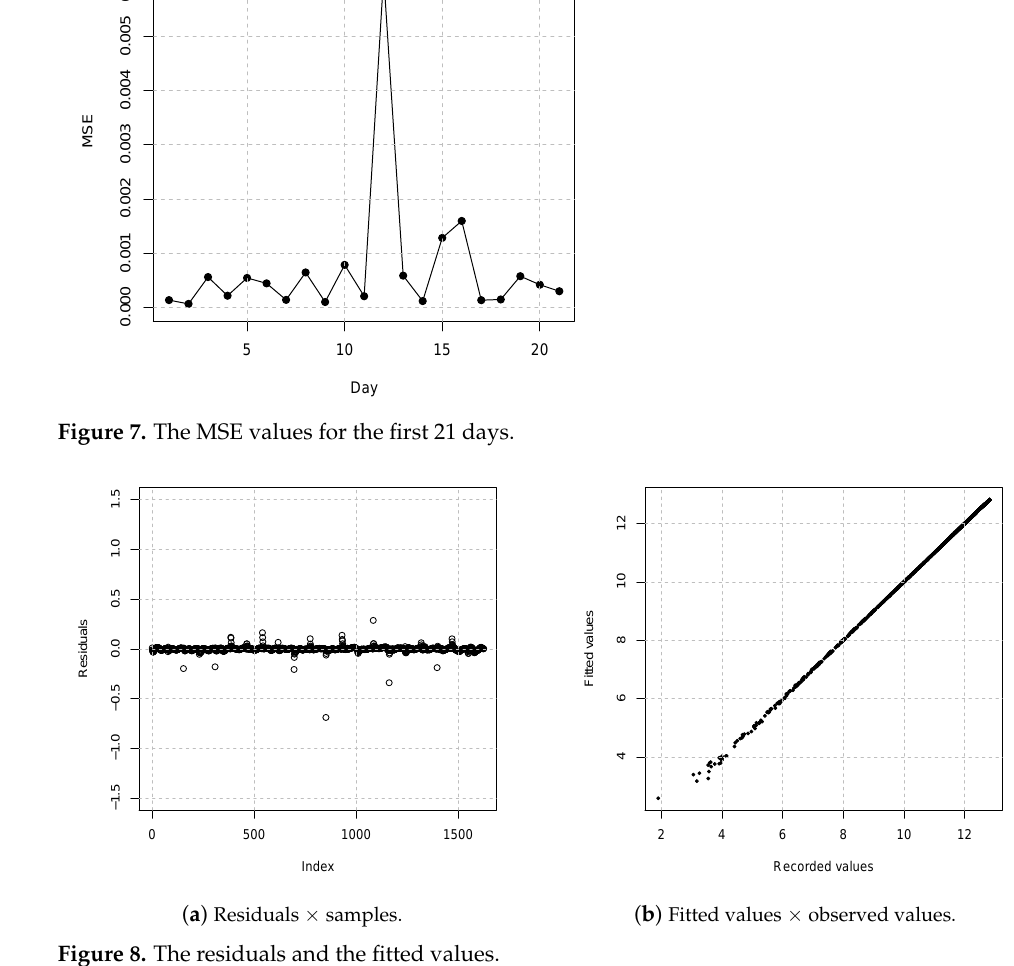
Figure 8. The residuals and the fitted values.